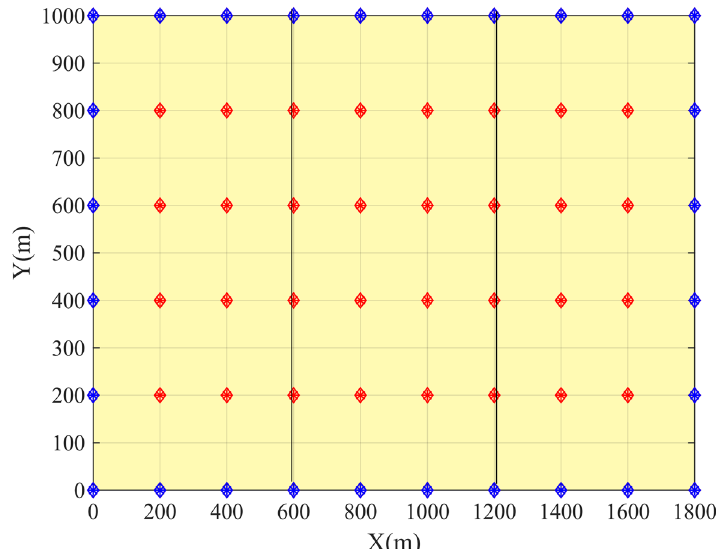
Fig. 4 Nodal distribution in standard